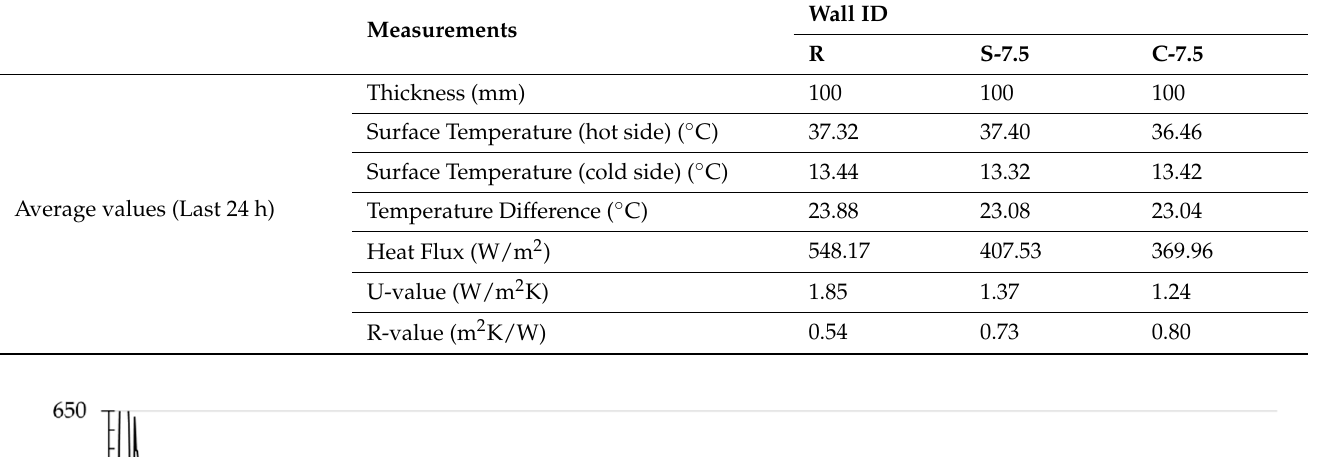
Table 6. Average results of last 24 h of the wall test.